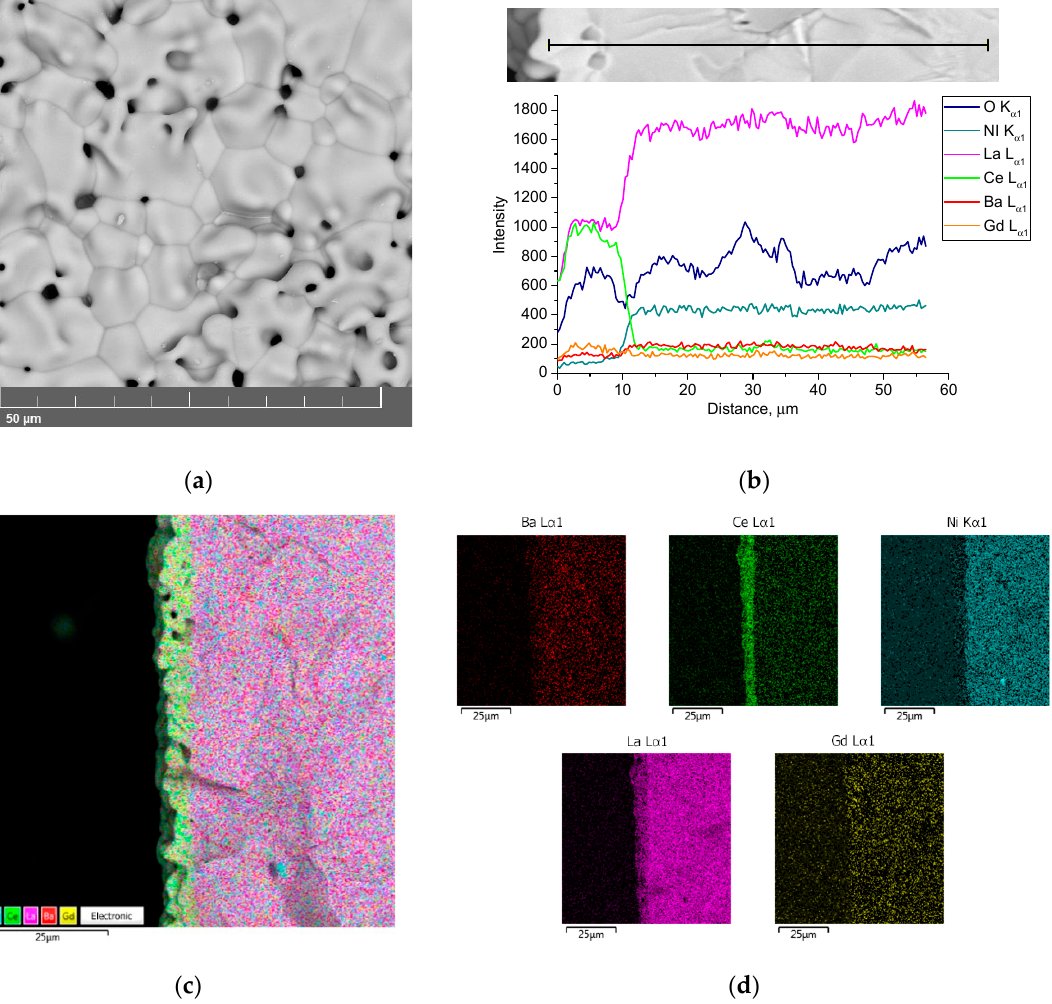
Figure 3. BCGCuO film structure on the LNO cathode (1450 ◦ C, 2 h): ( a ) film surface; ( b ) distribution of the elements in the film / substrate system in dependence on the distance from the film surface and EDX mapping image: ( c ) integrated; ( d ) individual elements.